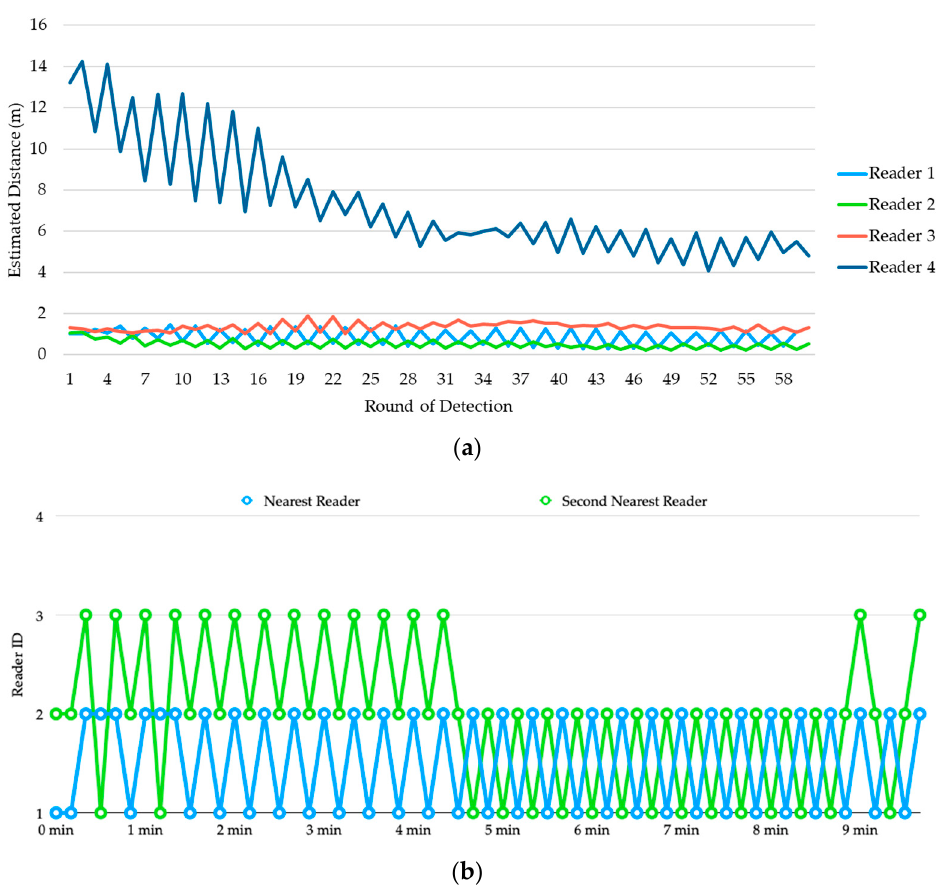
Figure 9. Experiment 1: ( a ) estimated distances of transmitter 1 from the four readers, ( b ) determination of occupancy for vehicle 1.